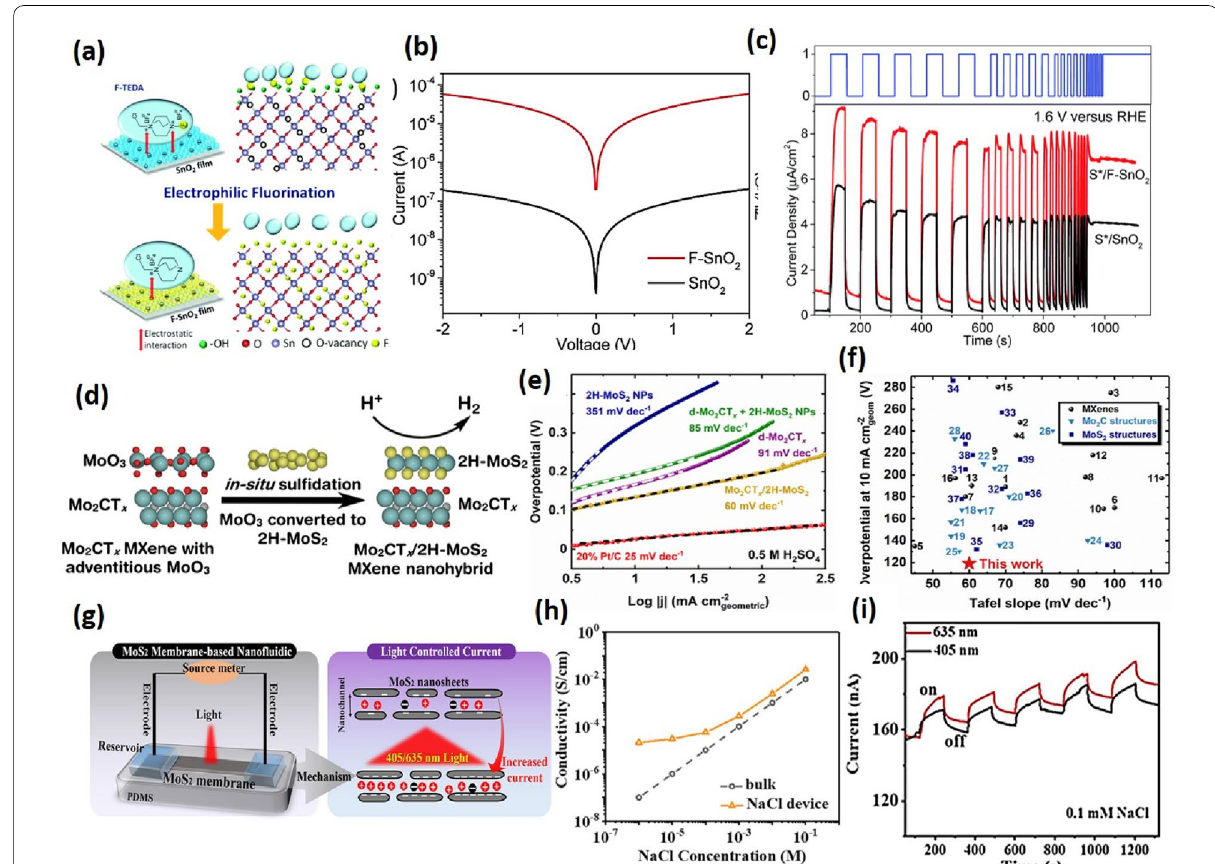
Fig. 7 a Schematic demonstrating the fluorination process of the SnO 2 film using the F-TEDA molecule as the fluorinating precursor. b I–V characteristics of SnO 2 and F–SnO 2 films, c J–t measurements of S*/SnO 2 and S*/F–SnO 2 . Figure adapted from ref [142] d Schematic representation of in situ sulfidations produce Mo2CTx/2H-MoS2 nanohybrid, e Tafel plot, f HER benchmarking of Mo2CTx/2H-MoS2 against other material [162] g Schematic illustration of ion transport through the nanochannel in the MoS2 membrane h Ionic conductivity of the MoS2 membrane in NaCl solution i Reversible switch of the ion transport under 405 and 630 nm light illumination in the NaCl solutions